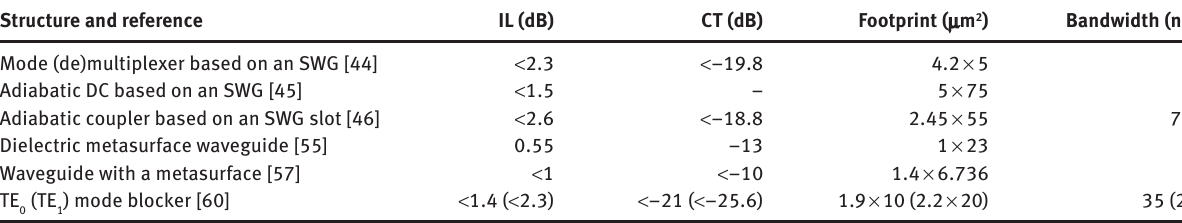
Table 2: Experimental results for various subwavelength structured mode multiplexers and converters. Structure and